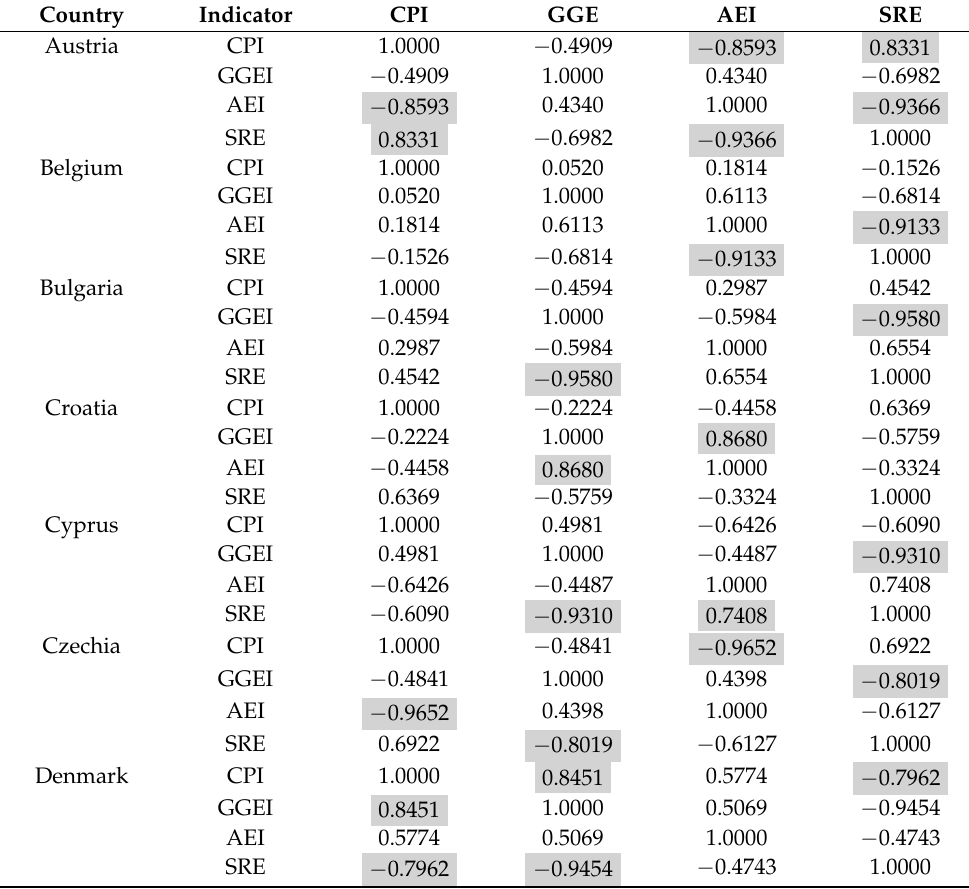
Table 1. Correlation matrices between the analyzed indicators in individual countries.